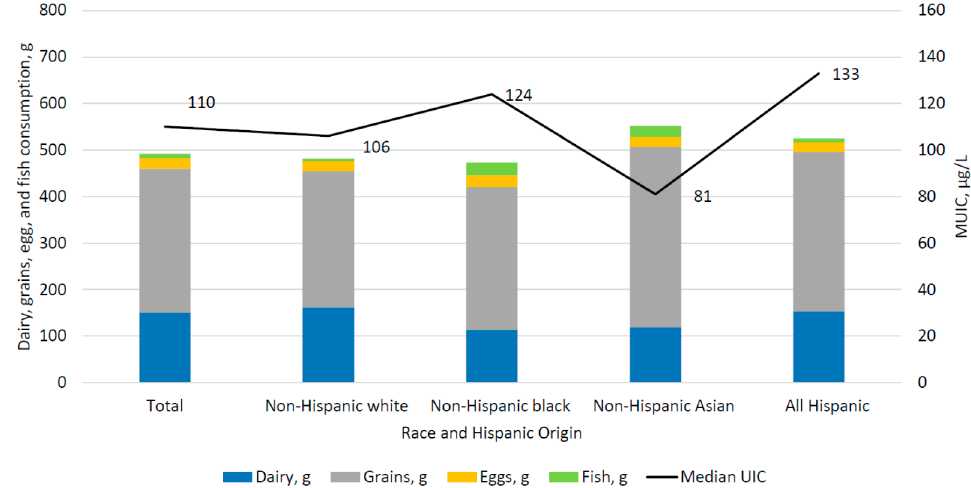
Figure 2. Median UIC and mean dairy, grains, egg, and fish consumption, by race and Hispanic origin among women aged 15–44 years, NHANES 2011–2014.